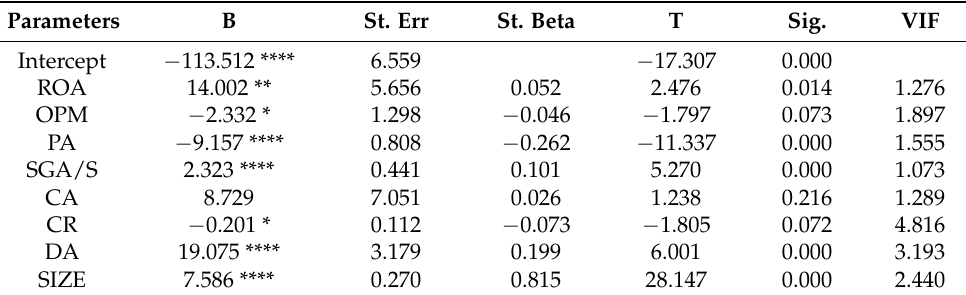
Table 5. Regression results for ESG_SC as dependent